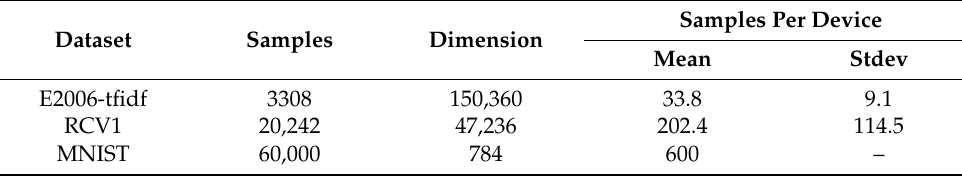
Table 2. Statistics of three real-world datasets in the federated setting.